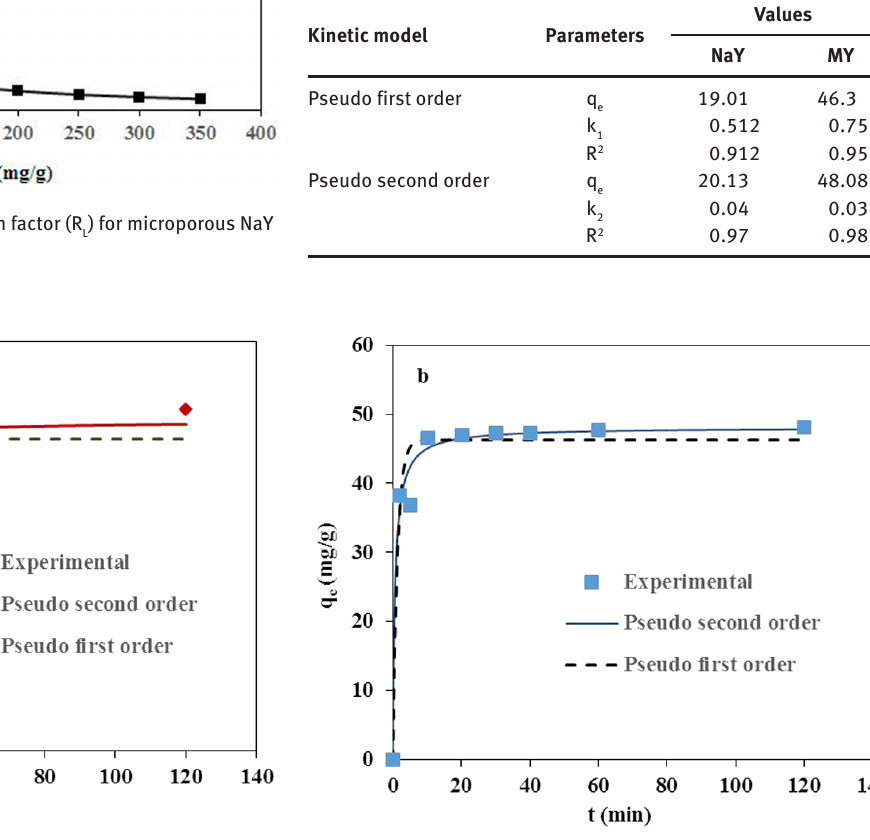
Figure 11: Pseudo-first order and pseudo-second-order kinetic models for (a) microporous NaY and (b) hierarchical